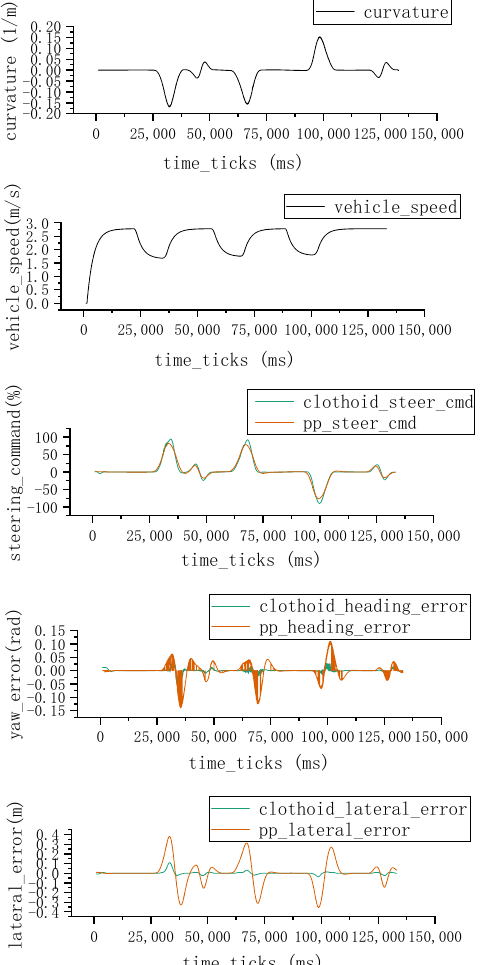
Figure 8. Speed limit 10 km/h trajectory tracking. Top first row: the curvatures along the field test road. Second row: actual speed of the vehicle during the trajectory tracking experiment under the speed limit of 10 km/h. It can be seen that the vehicle will slow down according to the curvature of the road ahead before entering the curve. Third row: steering wheel angle commands the comparison between the pure pursuit method and the method proposed in this paper. When tracking the curve, the method proposed in this paper increases the steering wheel angle control command later when entering the curve, and decreases the steering wheel angle control command in advance when leaving the curve, and the control amount given in the curve is also larger. It is because of this that the “cutting corner” problem suffered by the pure pursuit method is avoided. Fourth row: yaw angle deviation from the reference path point. The method proposed in this paper reduces the angle deviation to a large extent and avoids the problem of directional oscillation when turning, so as to improve the driving stability and riding comfort of the vehicle. Last row: lateral deviation from the reference path. The method proposed in this paper greatly reduces the reference path tracking error and improves the accuracy of vehicle path tracking